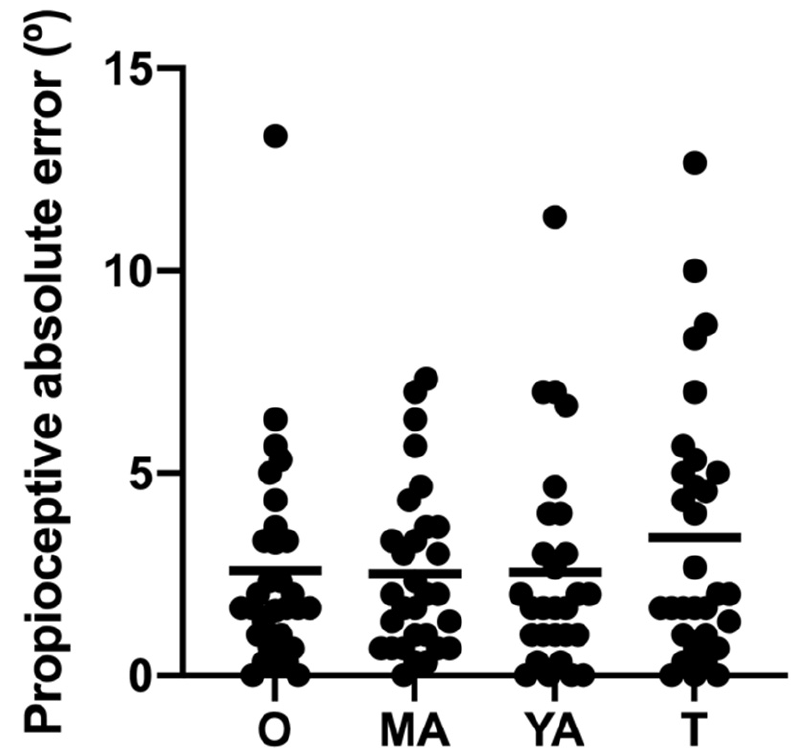
Figure 5. Performance on the proprioception test. The dots represent the individual scores for absolute error, and the horizontal lines represent the mean score for each group. Lower scores reflect a better performance on the task. O: Older adults; MA: middle-aged adults YA: young adults; T: teenagers. * p < 0.05. The calculations of the correlations show trivial, statistically insignificant relationships between the postural control and proprioception variables, ranging from r = 0.01 to r = 0.09. Weak correlations were found between the degree of repositioning error and proprio- ception and between the variables MV AP ROE, MV AP RCE and total area with regard to postural control. All the correlation matrices are shown in Table 2. Table 2. Correlation coefficients between proprioception and postural control with eyes open and